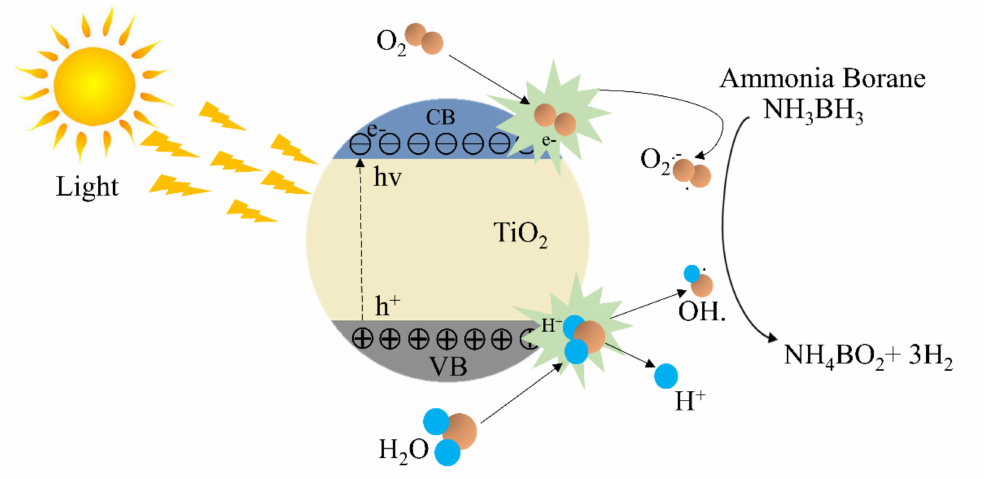
Figure 13. Photocatalytic steps for AB